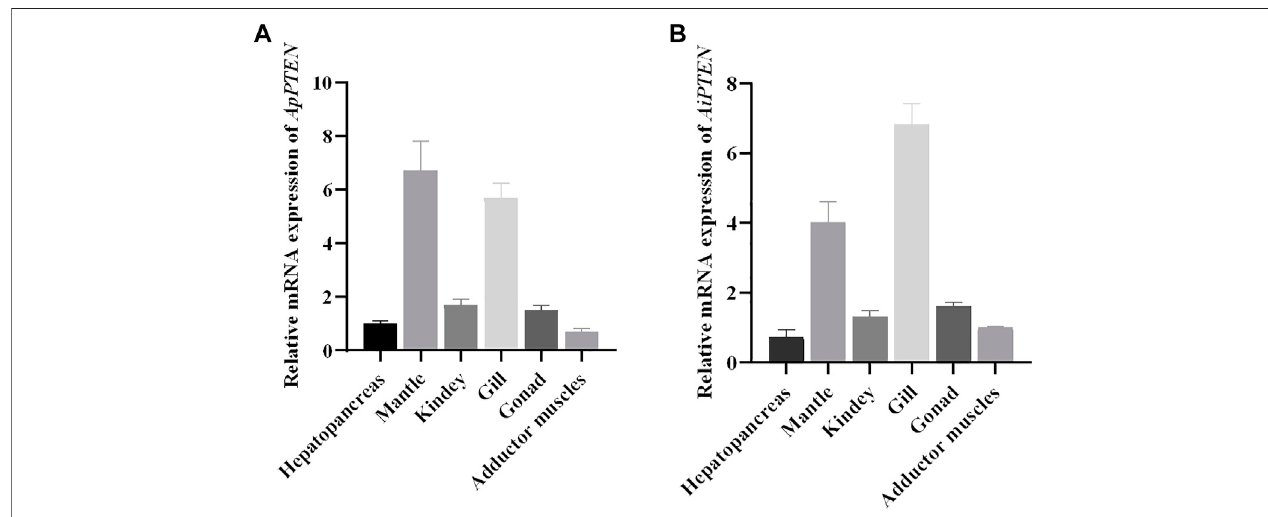
FIGURE 6 | Relative mRNA expressions of ApPTEN (A) and AiPTEN (B) in different tissues.